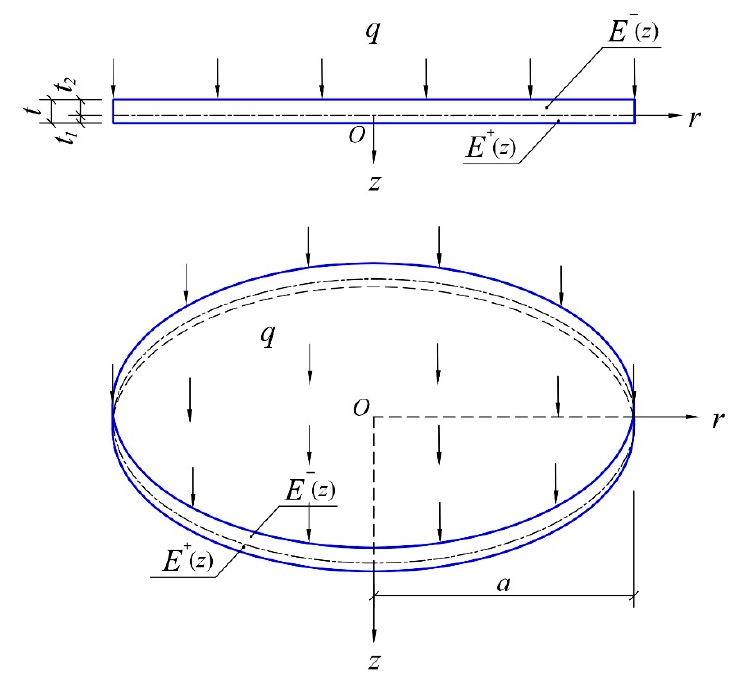
Figure 1. The bimodular FGM thin circular plate under a uniformly distributed load.